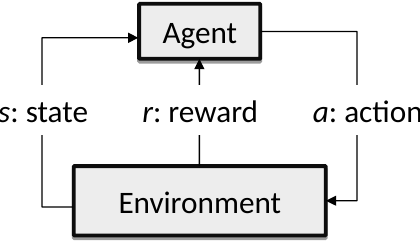
Figure 2. General interactions in Reinforcement Learning